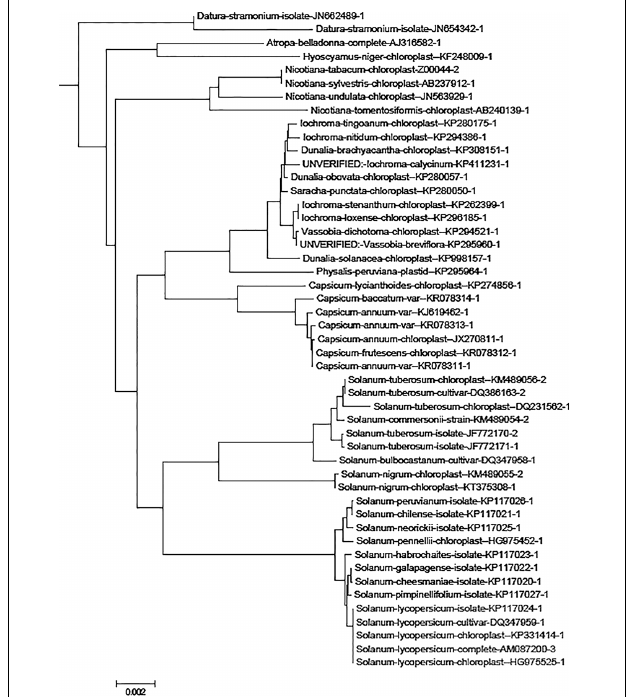
FIGURE 2 | The Solanaceae family subtree in the tree containing 1,719 plant chloroplast genome sequences. The genome name contains the NCBI GenBank name and the accession number. The sequences Solanum lycopersicum species sequences are highlighted in blue and other sequences (non-target species) are indicated in black. The neighbor-joining tree was constructed using MEGA version 6 (Tamura et al., 2013) and is based on distance matrix created with andi (Haubold et al., 2015).